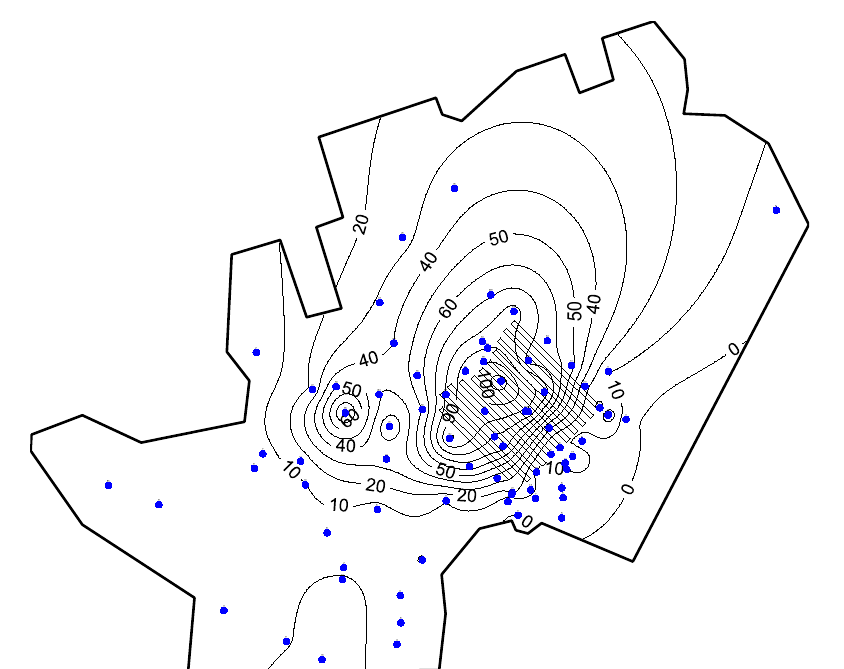
Figure 6. Water level contour measured from boreholes (blue dots).